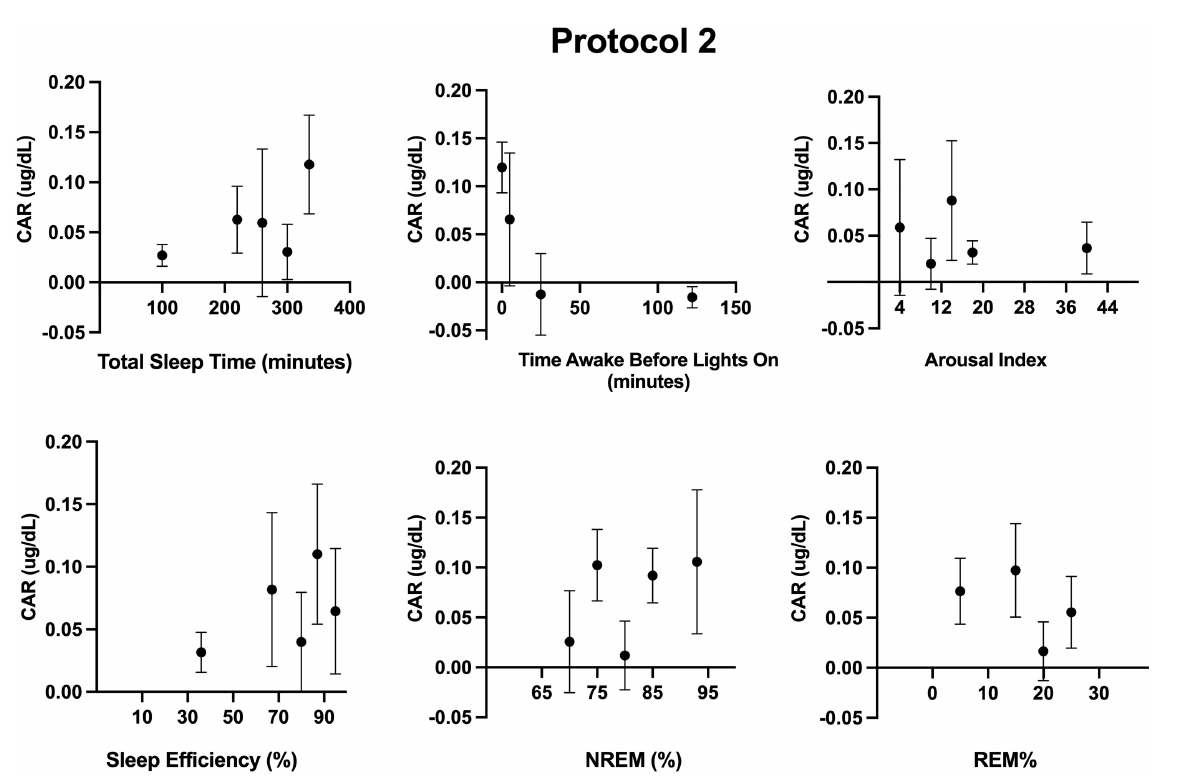
FIGURE4 Associations between measured sleep parameters during the five forced desynchrony sleep opportunities of protocol 2 and the cortisol awakening response (CAR). Participants’ binned data (binned into 4–5 intervals for a given sleep parameter, means ± SEM) are depicted as black circles. Binned data were averaged within an individual first, as an individual could contribute more than one point to each bin. Linear (see Table 2 ) and quadratic models were not